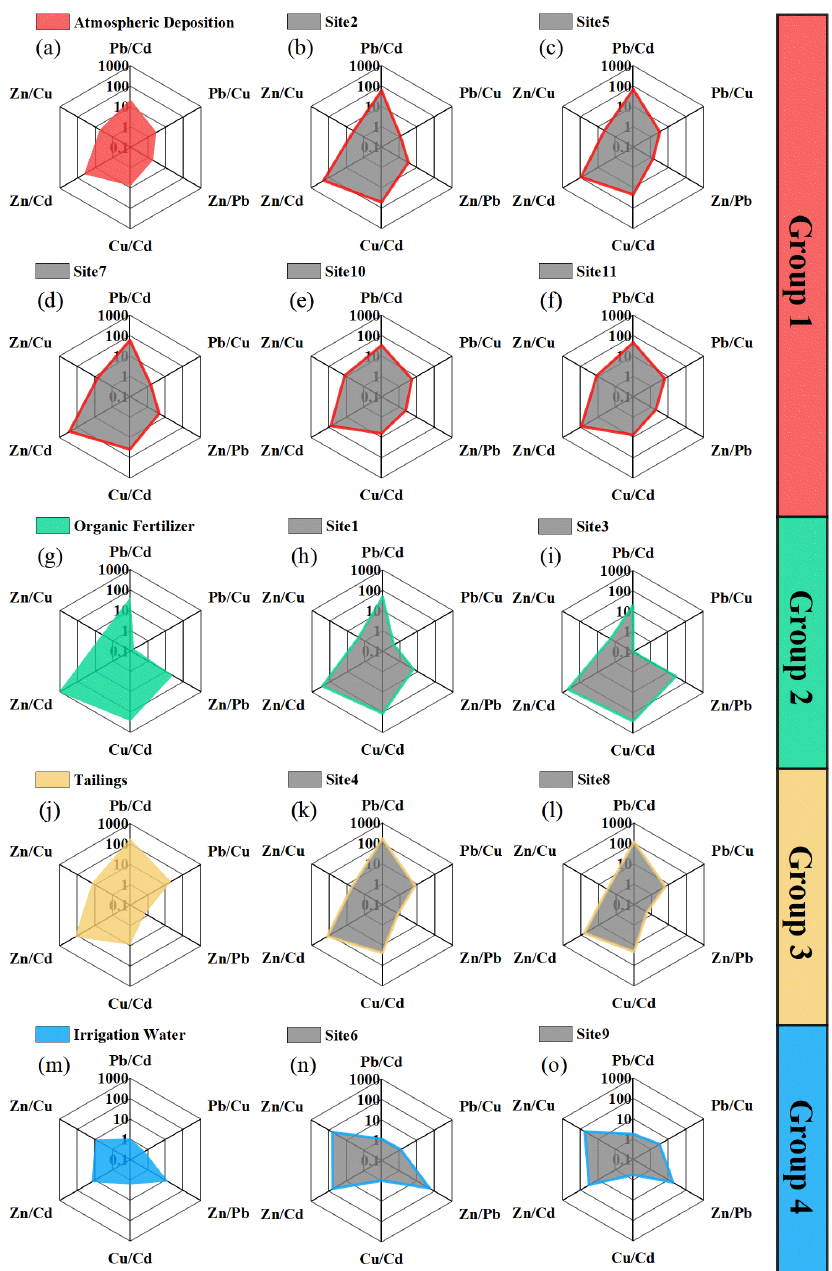
Figure 3. Radar plots of the ratios of heavy metals from different pollution sources ( a , g , j , and m ) and sampling sites ( b , c , d , e , f , h , i , k , l , n , and o ). Groups 1, 2, 3, and 4 reflect groups of sampling sites exhibiting similar radar plots as atmospheric deposition, organic fertilizer, tailings, and irrigation water,